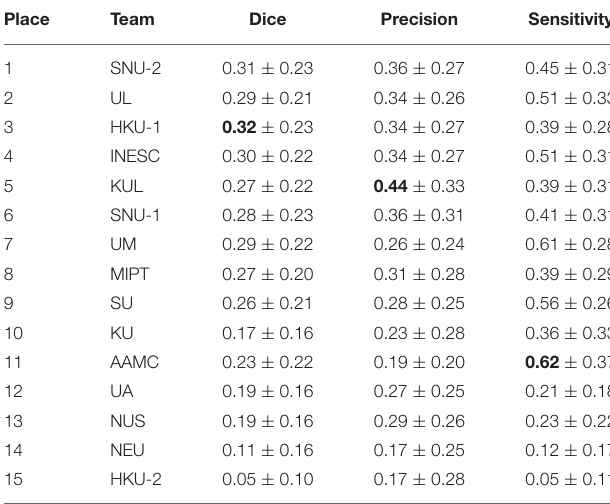
TABLE 6 | Leaderboard ISLES 2017: While the rank denotes the final value used to sort the teams performances relative to each other. Place Team